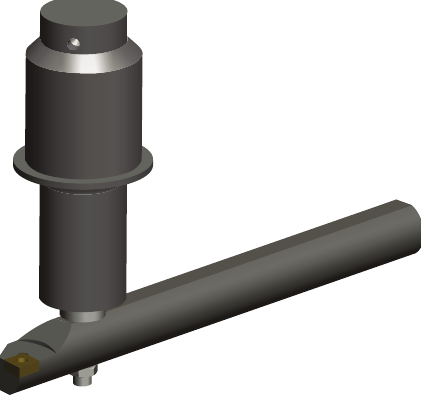
Figure 6: Ultrasonic horn clamped on tool holder.